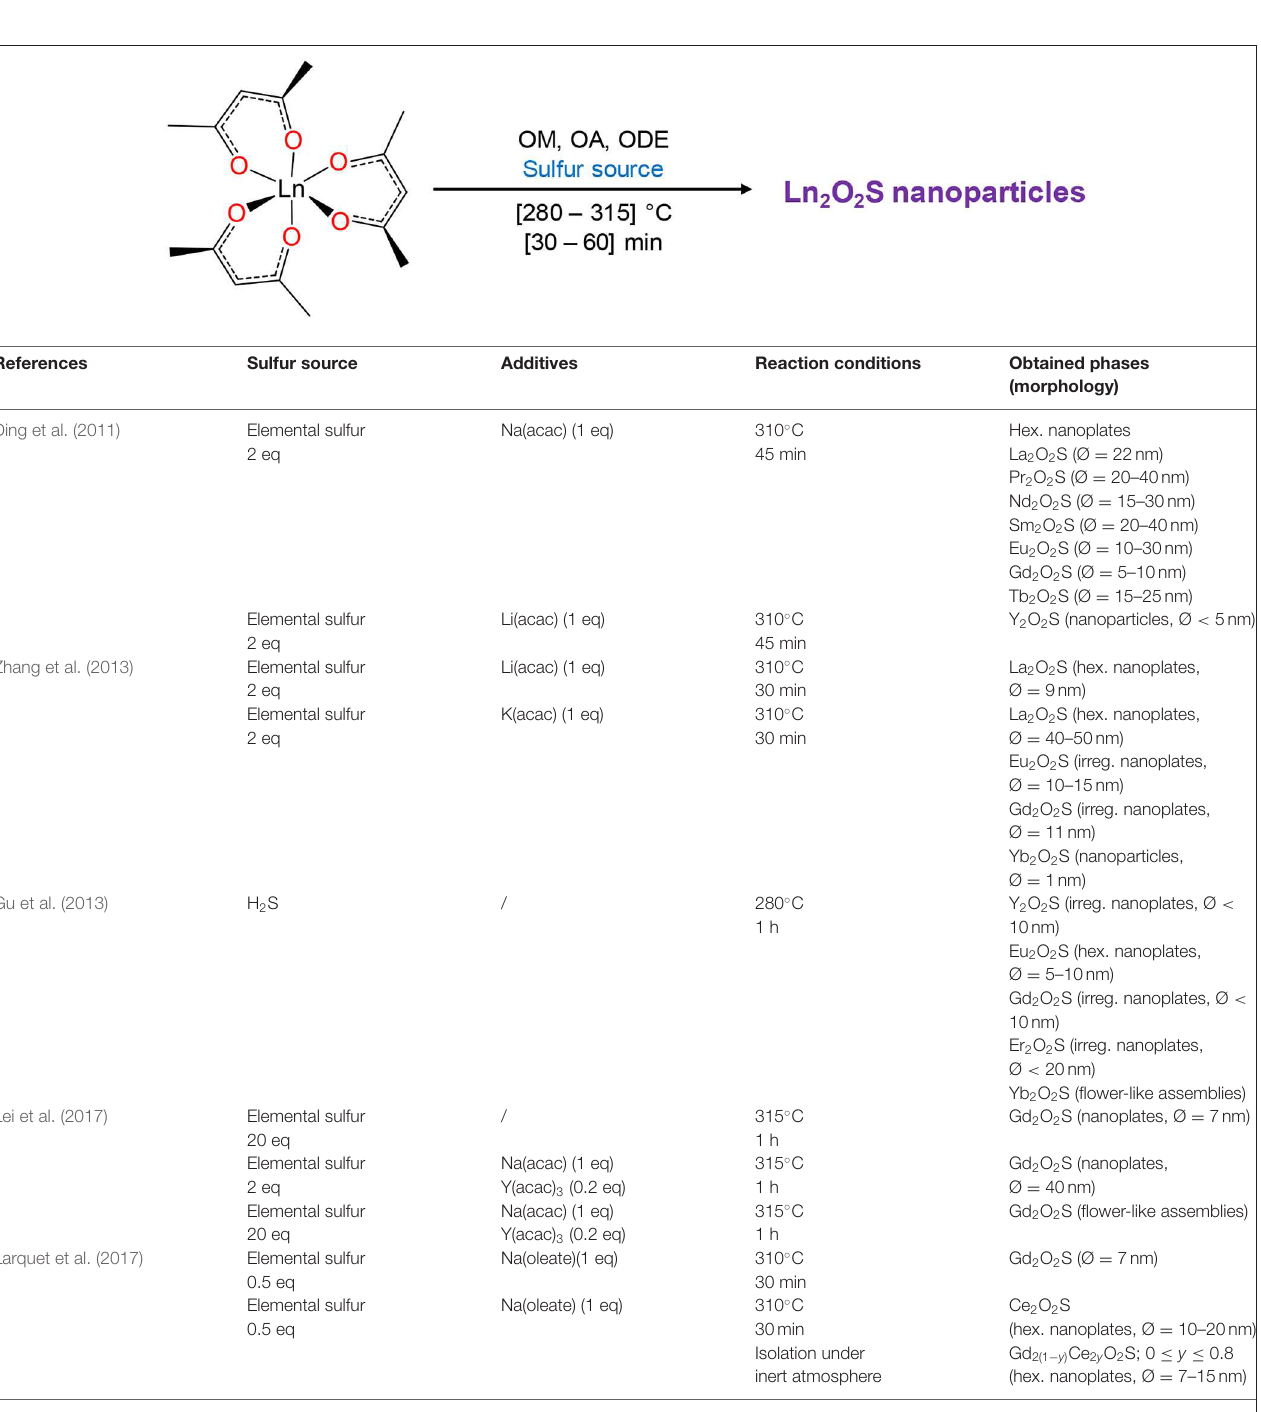
and evidencing the oxysulfide nature of the compound. Because excessive heating tends to stabilize sulfate or separate oxides and sulfides rather than crystallize an oxysulfide structure, the reported structures are mainly amorphous.